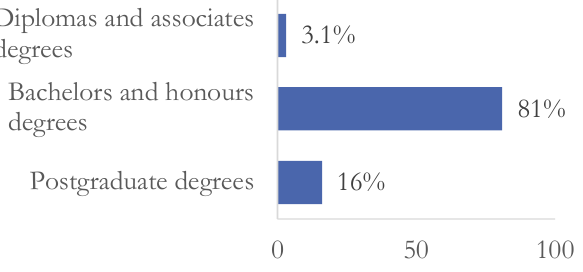
Figure 8 . Level of experience required in Australian block chain-related job ads between August 2017 and August 2018. Source: BGT data [7] Note: 68% of records have been excluded because they did not mention required experience.